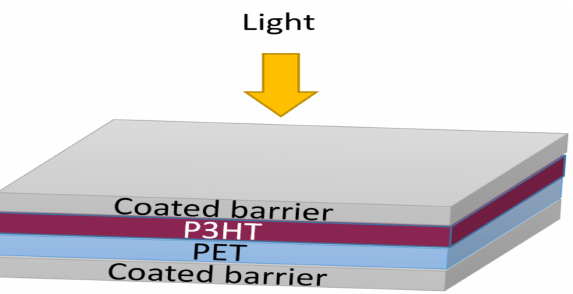
Figure 7. Schematic diagram P3HT film deposited on PET (125 µ m) substrate coated from both sides with barrier layers, where coated barrier represents PVB and PVB/mica